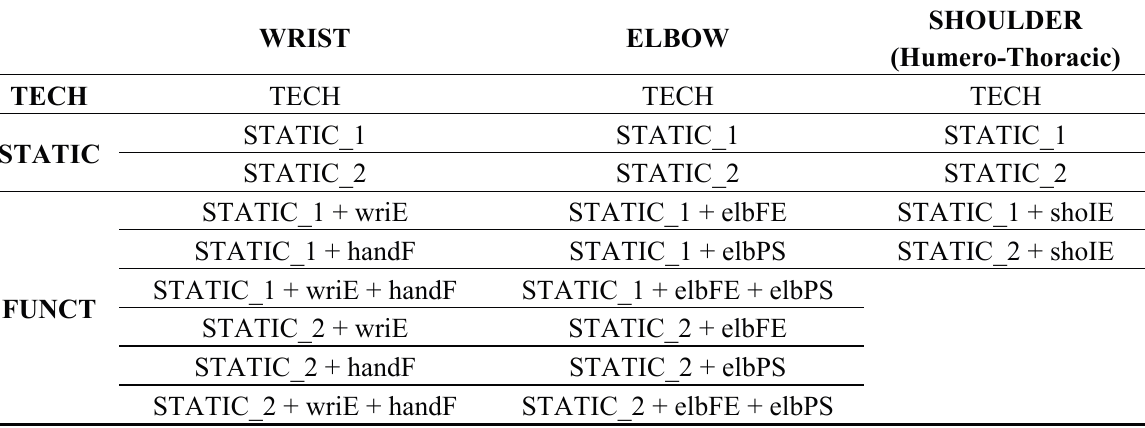
Table 1. The sensor-to-segment calibrations selected for each joint studied.